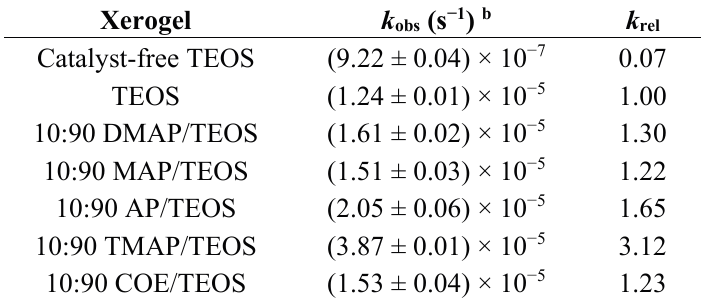
Table 5. Observed pseudo first-order rate constants ( k obs ) for bromination of 4-pentenoic acid ( 19 ) and relative rates ( k rel ) of bromination of 4-pentenoic acid ( 19 ) with catalyst 8 incorporated into varying xerogel formulations in pH 6.2 phosphate buffer a